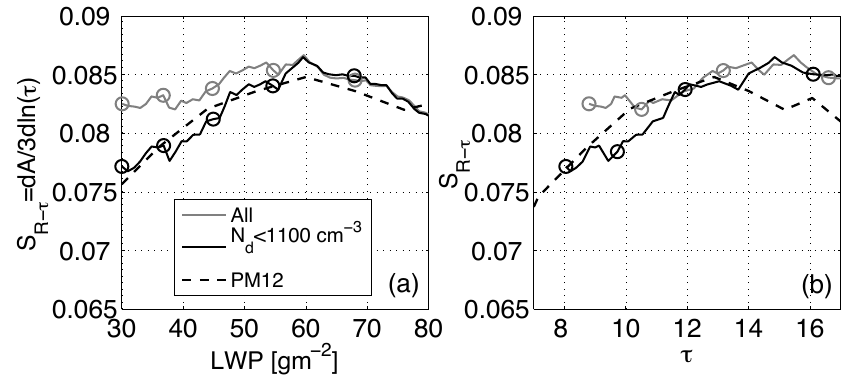
Fig. 14. Albedo relative susceptibility as a function of (a) LWP and (b) τ (binned as a function of LWP). Gray and black lines correspond to calculation made with all the data, and N d < 1100cm − 3 , respectively. Black dashed lines (PM12) are relative susceptibilities reported in Painemal and Minnis (2012) over the Southeast Pacific near the coast. Circles indicate bins without overlapping.